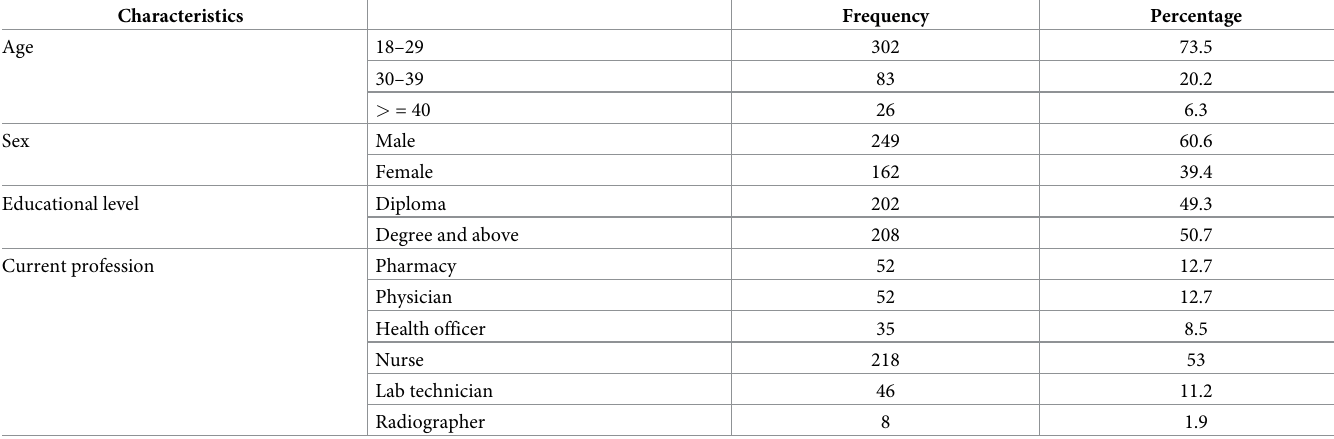
Table 1. Socio-demographic characteristics of healthcare workers in Gamo Gofa Zone, Southern Ethiopia, 2019 (n = 411). Characteristics